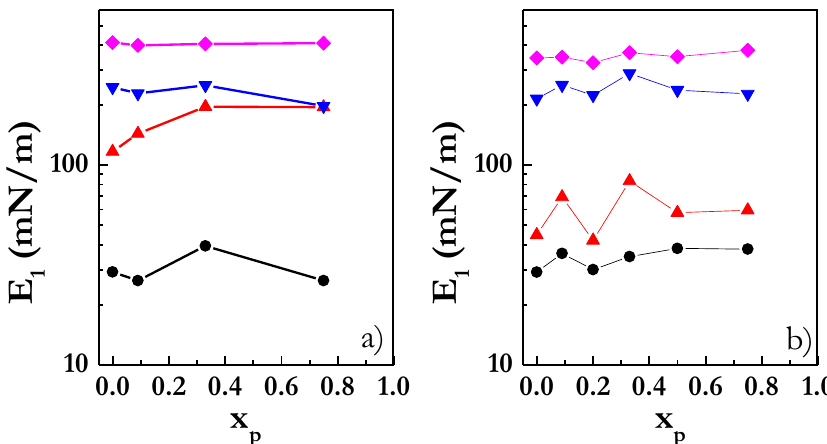
Figure 10. E 1 dependences, obtained using Equation (4), on the particle weight fraction, x p , for different values of the surface pressure Π for DPPC monolayers upon incorporation of CB ( a ) and SiO 2 ( b ): ( ―●― ) 3 mN/m, ( ―●― ) 7.5 mN/m, ( ―●― ) 20 mN/m and (―●―) 40 mN/m. Notice that the lines are guides for the eyes.